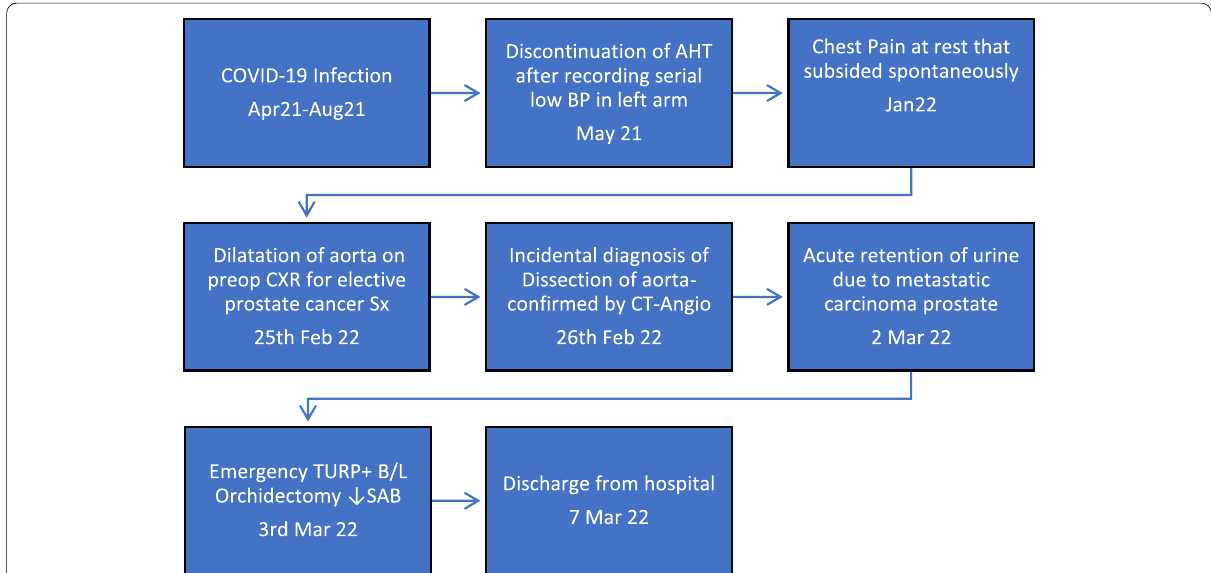
Fig. 1 Timeline of events (AHT, antihypertensives; BP, blood pressure; CXR, chest radiograph; SAB, subarachnoid block; TURP, transurethral resection of